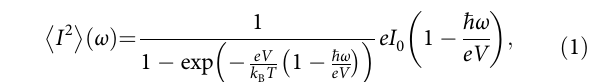
Supplementary Fig. 10 emission spectra of antennas with different widths showing different emission frequencies. A cutoff of light emission is expected around eV / h (indicated by a vertical dashed line in Fig. 4a – f for inelastic light emission) but not observed. The spectrum is signi fi cantly broadened and shifted from the theoretical eV / h value by the fi nite temperature (300 K) and by the antenna resonance. When repeating the simulation at 0 K as shown in Supplementary Fig. 9, a clear cutoff is observed. For the sake of comparison, we plot in Fig. 4d – f the theoretical emission spectrum of a planar junction at three different voltages multiplied by a factor of 500. This shows the two roles of the antenna: spectral control and ef fi ciency enhancement.